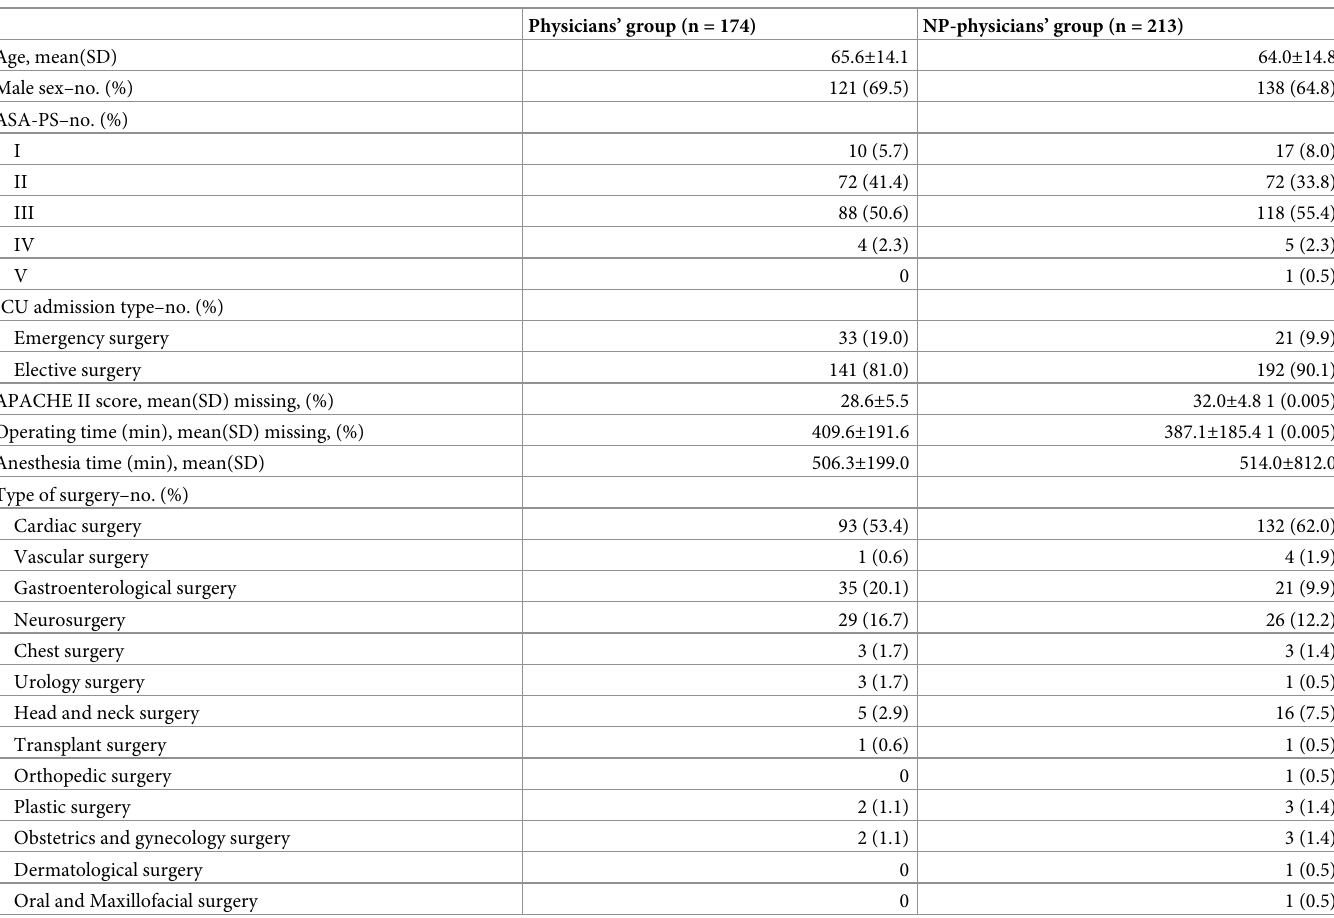
Table 1. Characteristics of patients in the